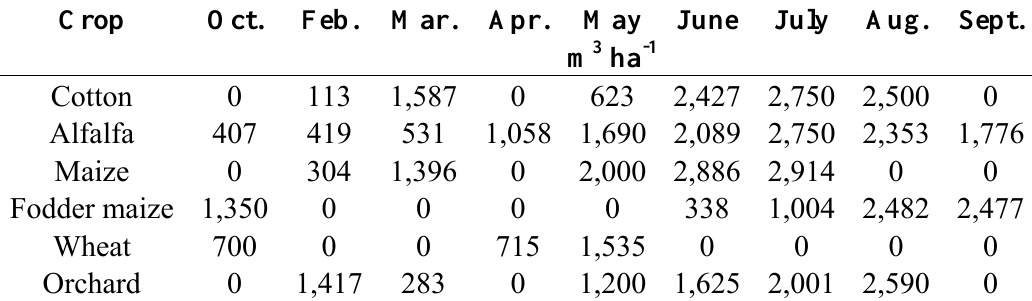
Table 4. Crop irrigation water